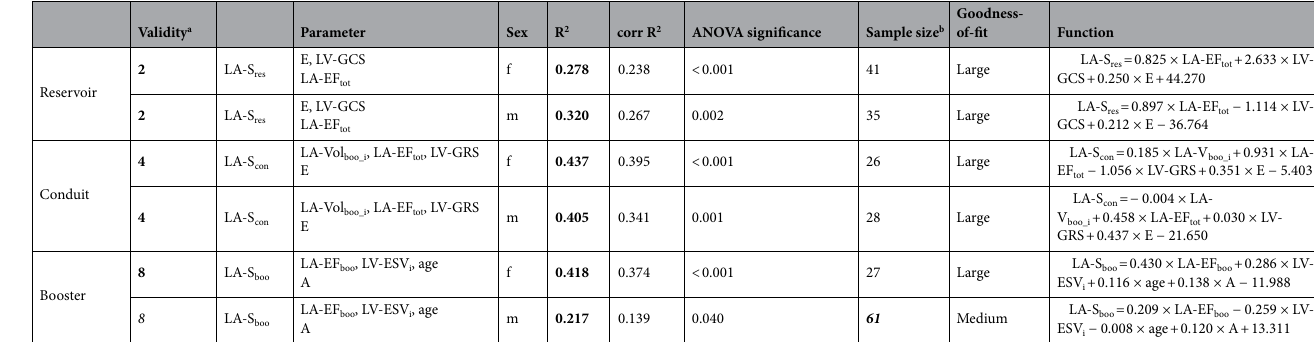
women in contrast to men. Upon conducting a mediator analysis between the impact of sex or indexed muscle mass on the strain, they identified indexed muscle mass as a partial mediator variable in contrast to gender.